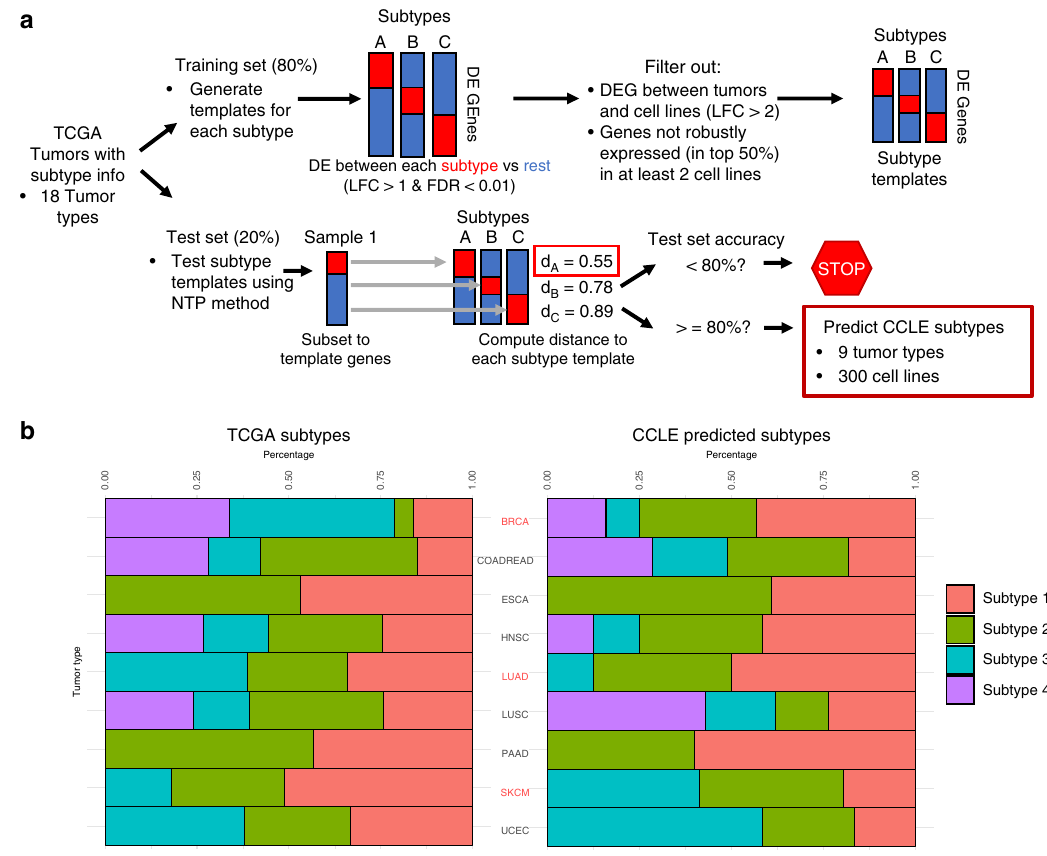
Fig. 3 Cell line tumor subtype predictions. a Overview of the tumor subtype prediction method used in the study. TCGA tumors are divided into a training (80%) set to identify genes that are upregulated in each tumor subtype compared with the other tumor subtypes (LFC > 1, FDR < 0.01). Subtype templates are then fi ltered to remove genes that are differentially expressed between primary tumor samples and cell lines (LFC > 2) and genes that are not robustly expressed in at least two cell lines to generate cell line relevant subtype templates. These subtypes of the TCGA test set (20%) are then predicted using the Nearest Template Prediction method and if classi fi cation accuracy is greater than 80%, the gene templates are then applied to the CCLE cell lines to predict the cell line subtypes. b The proportion of tumor subtypes within the TCGA cohort (left) and the predicted tumor subtypes in the CCLE cell lines (right) for tumor types with prediction accuracy greater than 80%. The tumor types highlighted in red (BRCA, LUAD, SKCM) have signi fi cantly different proportions of subtypes when comparing the TCGA subtypes to the CCLE predicted